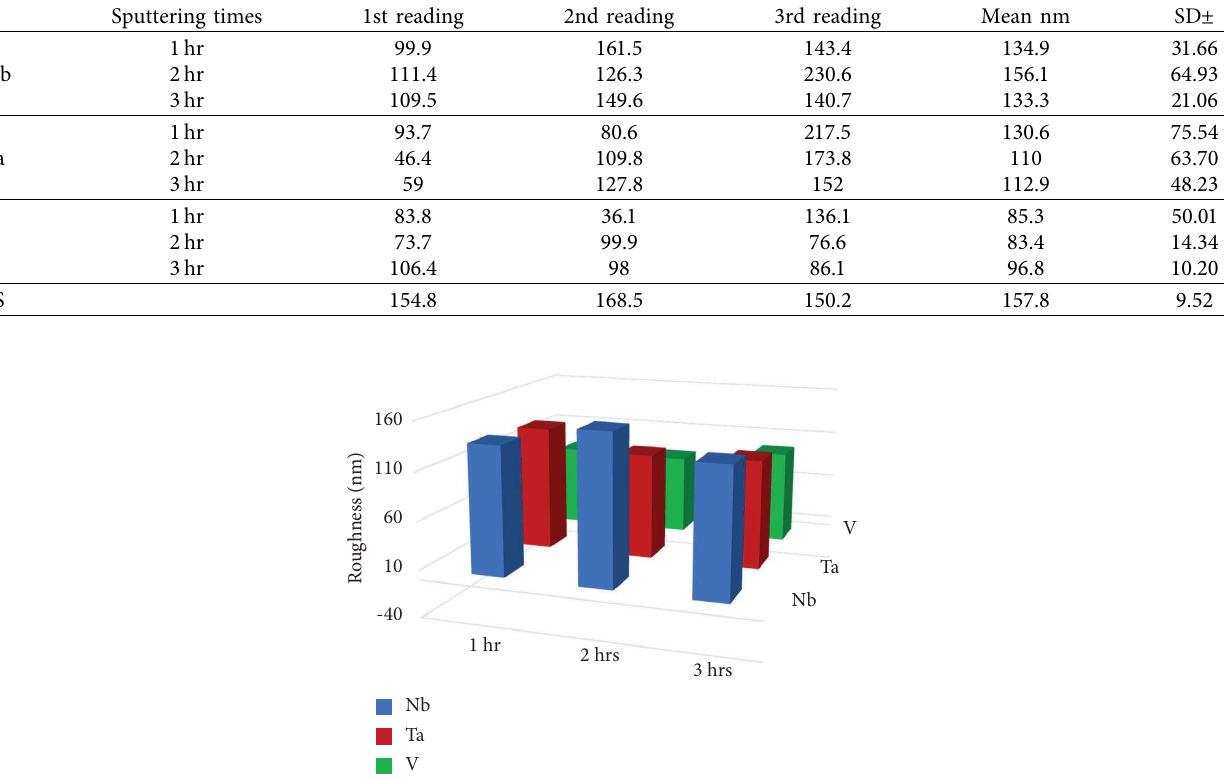
Figure 9: Comparison between sputtering time and surface roughness of Nb, Ta, and V coatings at 1, 2, and 3hours of plasma